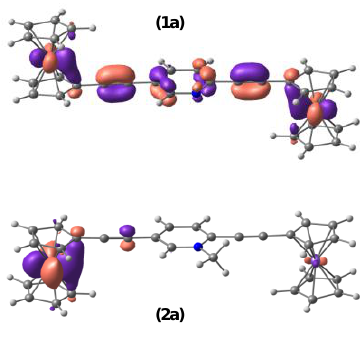
Figure 3. The highest occupied molecular orbitals (Contour value = 0.04) for compounds 1a (top) and 2a